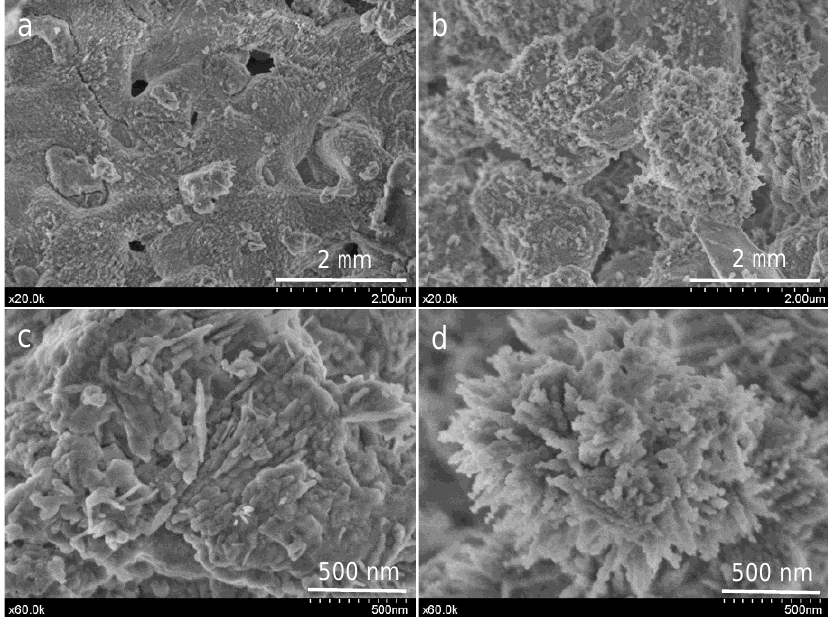
Figure 7. FEG-SEM observations at different magnifications of unhydrated ACaNO-HNO formu- lation: ( a , c ) secondary electron (SE) images of the material without post-synthesis treatment; and ( b , d ) SE images of the material after EPT.